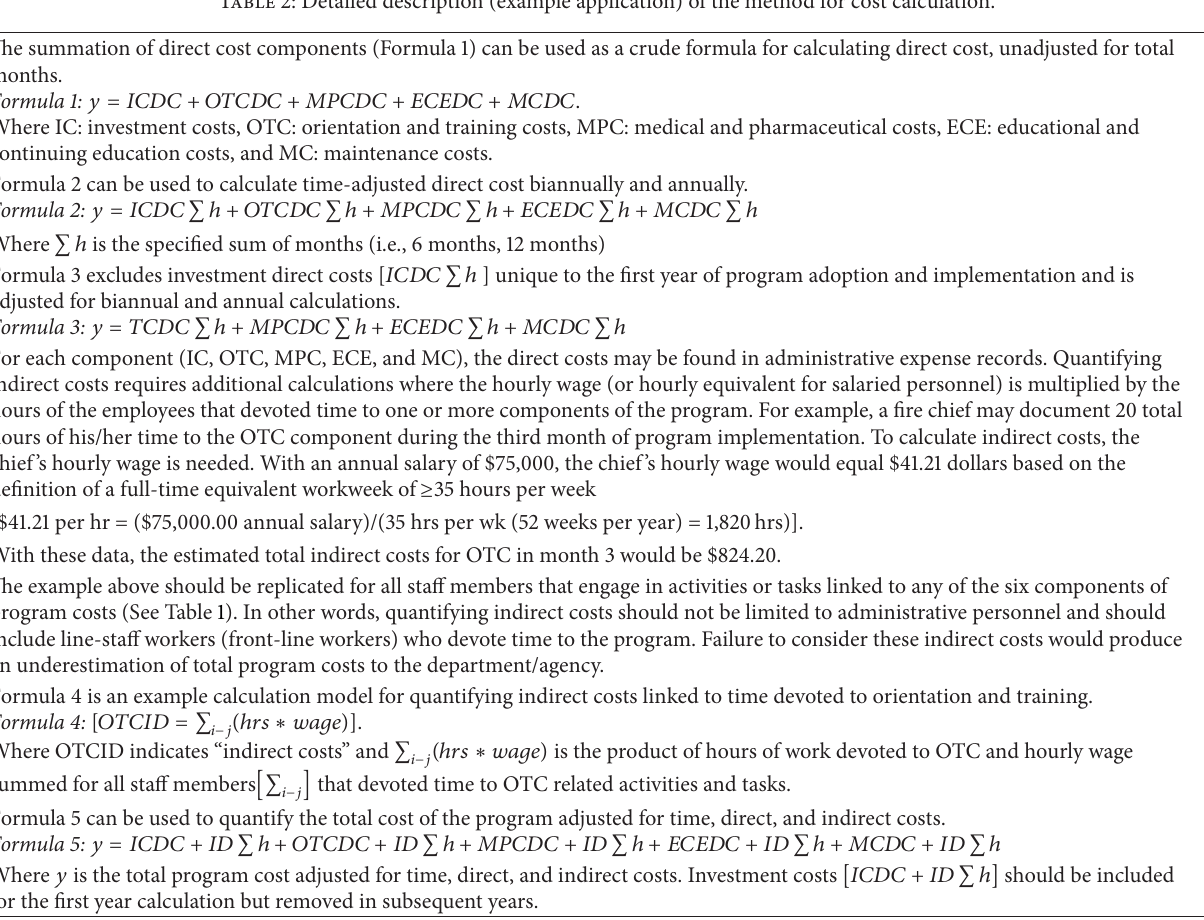
Table 2: Detailed description (example application) of the method for cost